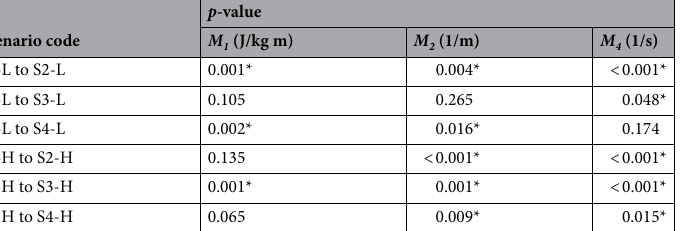
Table 5. p-values from a t-test associated with changes in boulder concertation for a given flow rate. M 1 is the kinetic energy gradient metric, M 2 is the normalized kinetic energy gradient metric, and M 4 is the modified recirculation metric. (*) indicates the change is statistically significant assuming a significance level of 0.05.